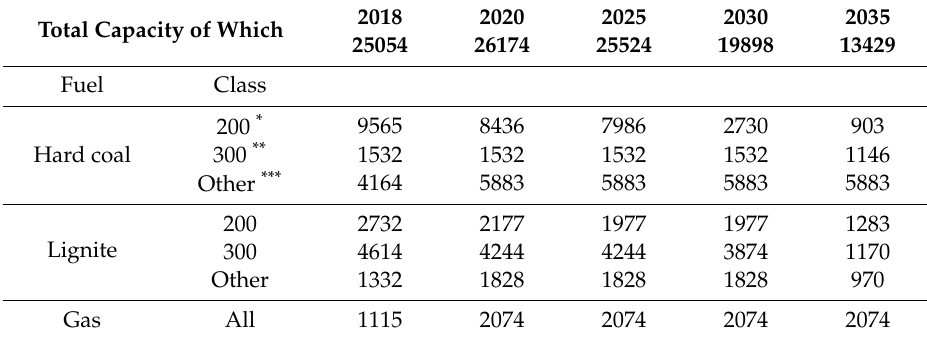
Table 3. Installed capacity in JWCD units with a focus on coal-fired plants (MW).